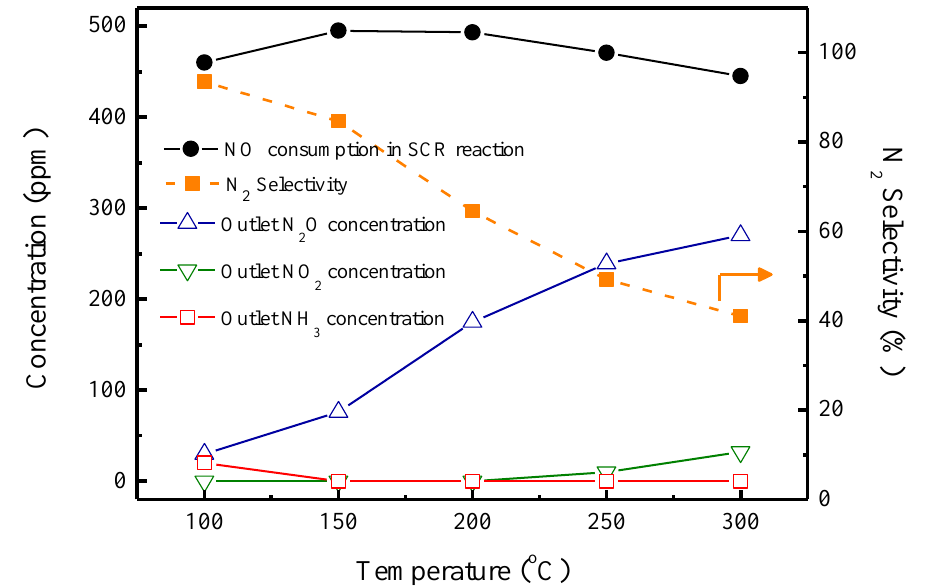
Figure 3. NO consumption and outlet gas concentrations in the NH 3 -SCR reaction without SO 2 over MnFe/TiO 2 catalyst at different reaction temperatures. Reaction conditions: Reaction temperature = 100~300 ◦ C, [NO] = 500 ppm, [NH 3 ] = 500 ppm, [O 2 ] = 10%, balanced with N 2 , and GHSV = 50,000 h − 1